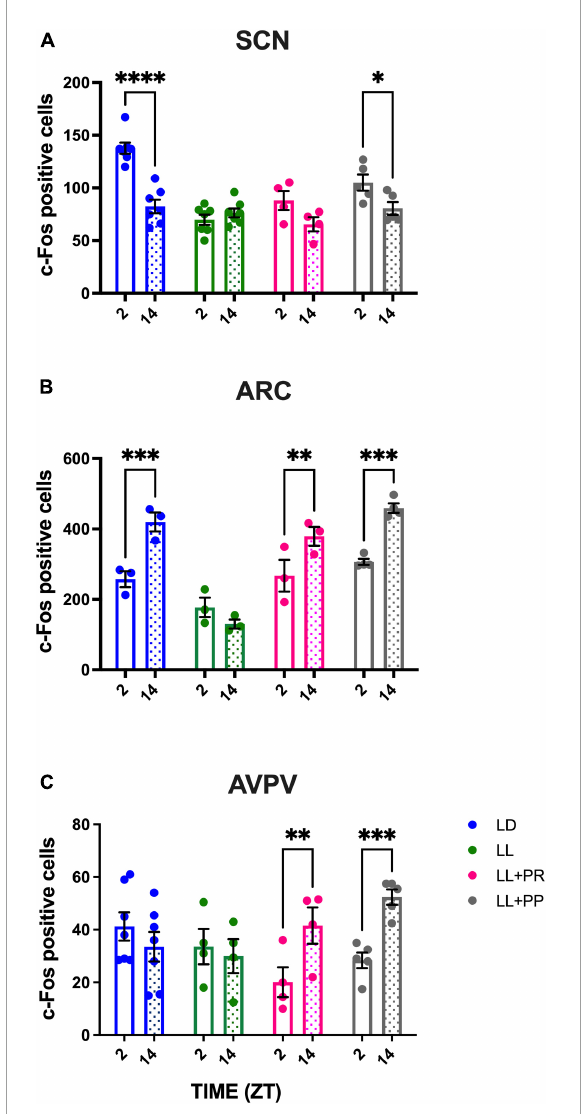
FIGURE7 Day–night c-Fos positive cells in (A) the suprachiasmatic nucleus (SCN), (B) the arcuate nucleus (ARC), and (C) the posterior ventral preoptic area (AVPV), in rats exposed to a light–dark cycle during the baseline (BL, blue bars), to constant light (LL, green bars), to LL followed by 3 weeks of 12-h feeding protocol distributed in four pulses feeding events every 3 h as a rescue strategy (LL + PR, pink bars), or to LL simultaneously to four food pulses as a preventive strategy for 6 weeks (LL + PP, gray bars). For each group, empty unfilled bars represent day (ZT2) and dashed bars represent the night (ZT14). Data are expressed as the mean ± SEM; n = 3–4/time/group. Asterisks indicate a statistical difference between the day and the night values in the specified group; * P < 0.01, ** P < 0.001; *** and **** = P <